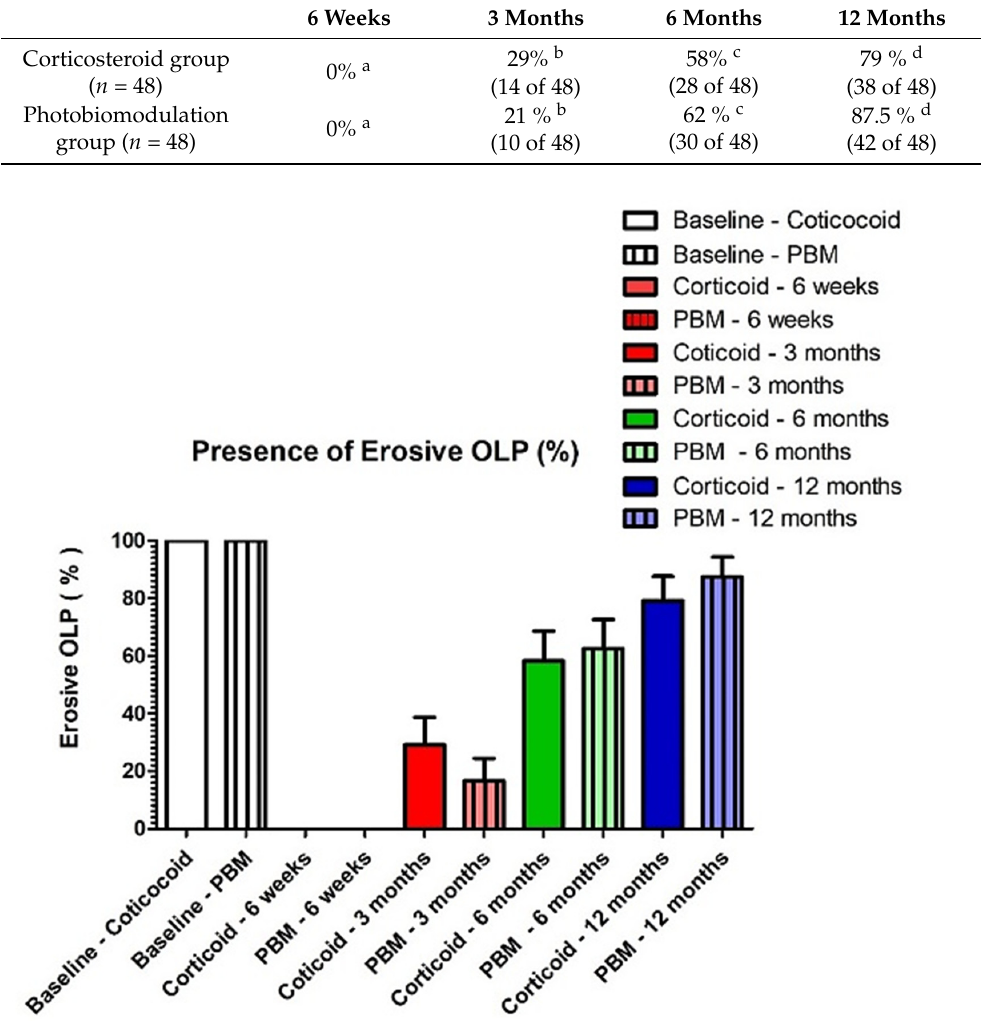
Figure 4. Recurrence rate of erosive and painful OLP at different periods of